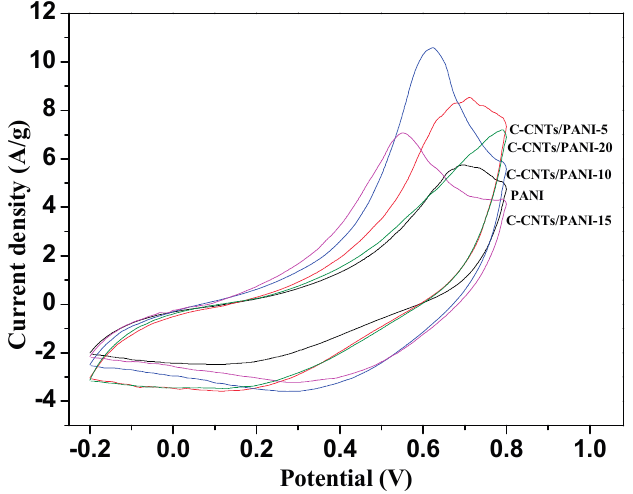
Figure 7. Cyclic voltammetry (CV) curves of the C-CNTs/PANI composites electrodes at scan rates of 10